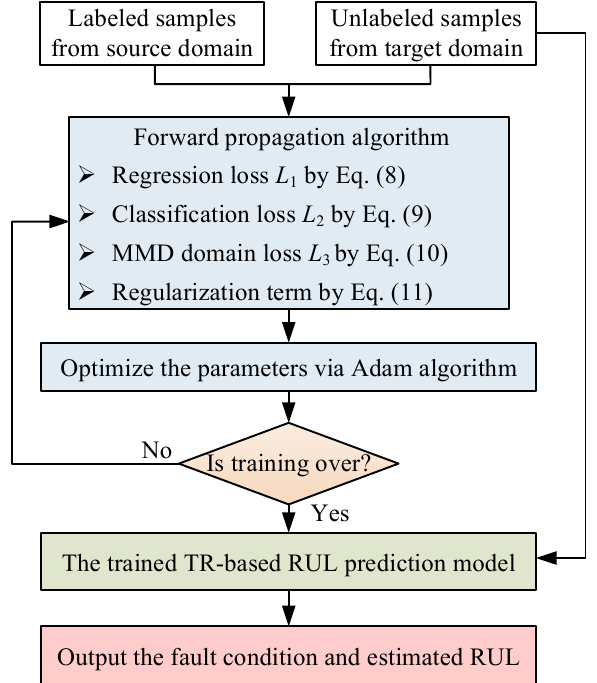
Figure 4. Flowchart of the proposed TR-based RUL prediction framework.